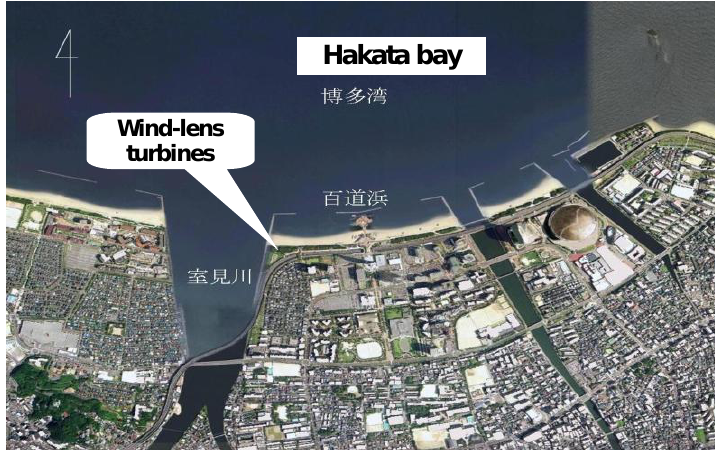
Figure 18. Computational domain. Prevailing wind is from north along x -direction. The inflow condition is 1/7 power law. The number of grid points is 161 × 201 × 51. The grid resolution is Δ x = Δ y = 17.5 m in horizontal directions and Δ z vertical direction. The Reynolds number based on the highest building h is Re = 10,000 in the